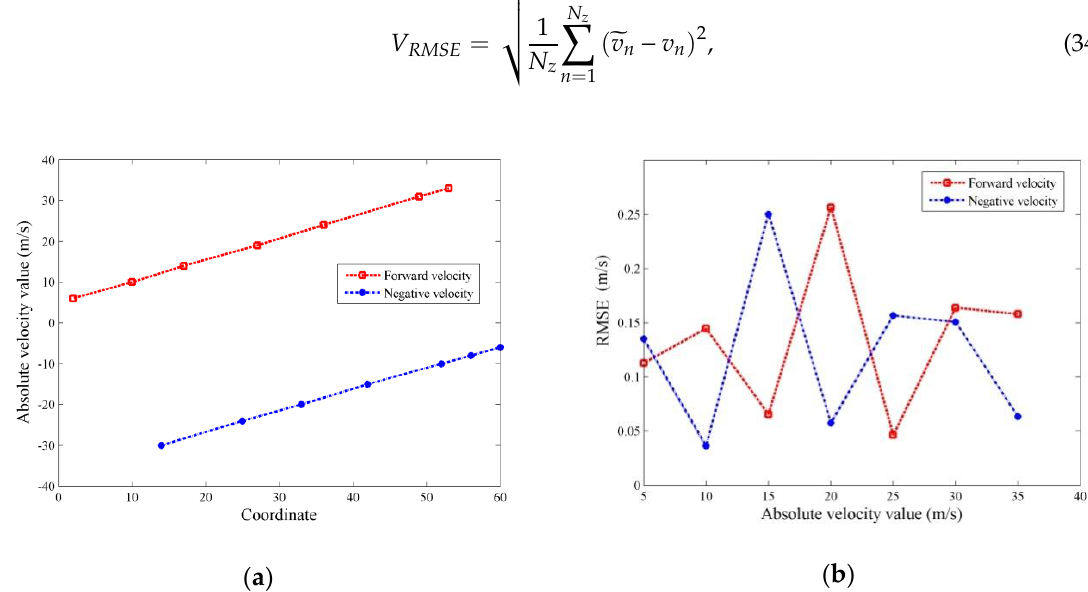
Figure 3. Target speed estimation: ( a ) Relationship between coordinate and speed; ( b ) speed estimation error.